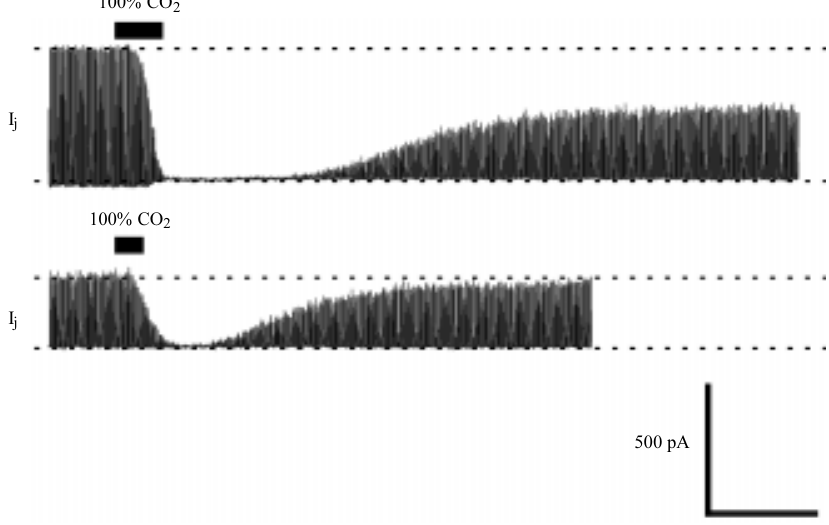
Figure 7 - Two recordings from a Neuro-2a cell pair with I j in re- sponse to V j steps of +25 mV. Application of 100% CO 2